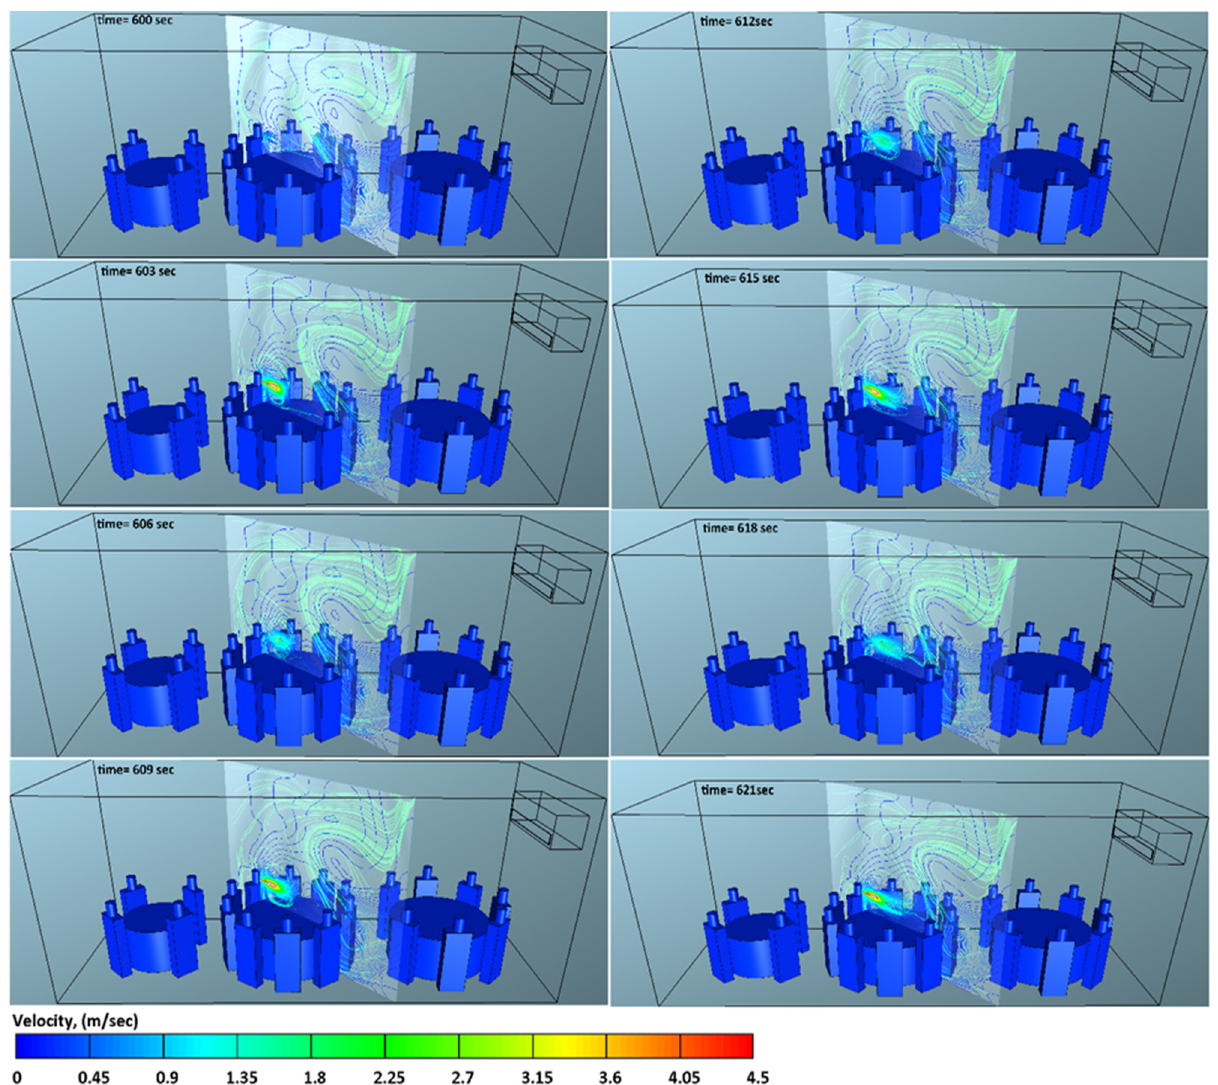
Figure 16. The effect of sneezing on airflow streamlines velocities at different time steps, case-4.